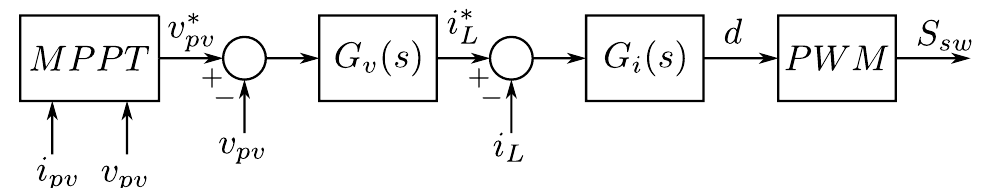
Figure 7. Block diagram of the cascaded PI controller scheme for the DC/DC boost